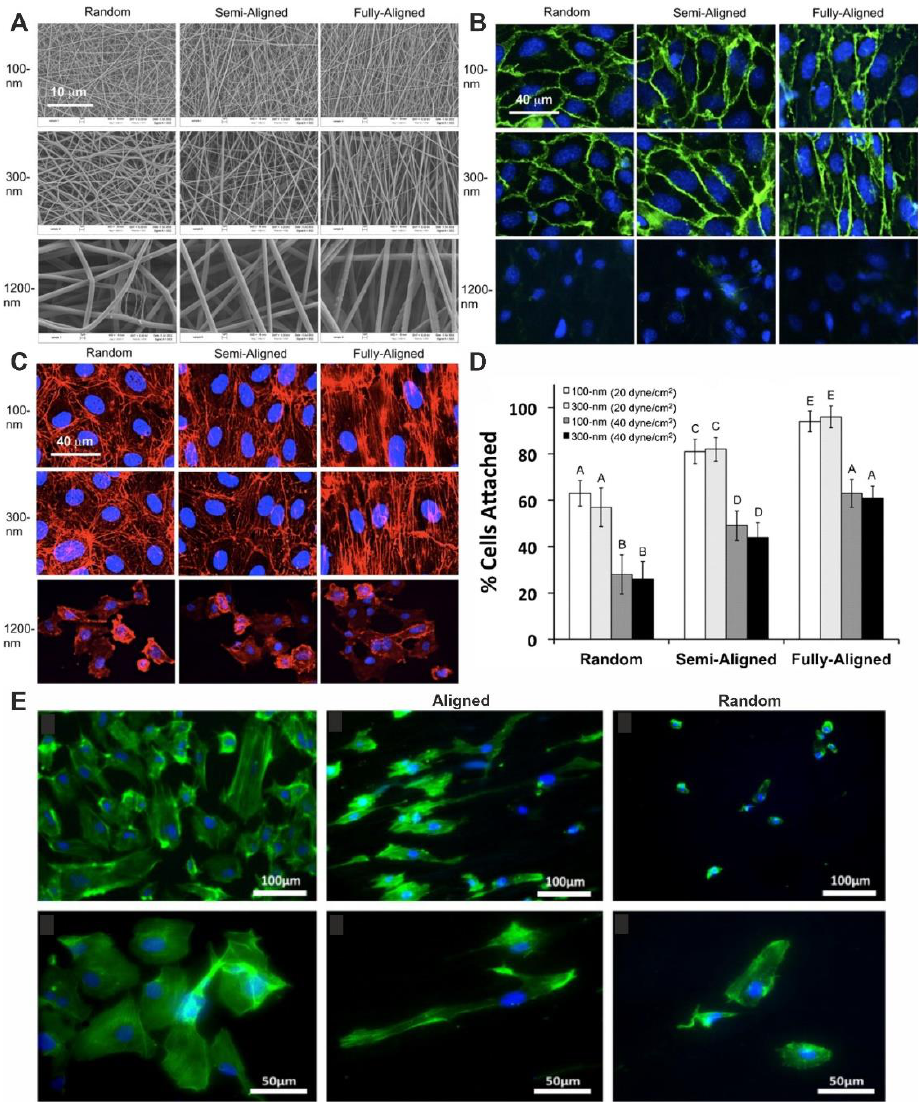
Figure 4. The effect of the scaffold’s fiber orientation on HUVEC morphology and alignment on electrospun scaffolds. The influence of fiber orientation and medium flow on interaction of endothelial cells with scaffolds (reprinted from Ref. [49]. Copyright © 2013 Biotechnology and Bioengineering Inc. Published by Wiley Periodicals). SEM image of electrospun PCL/collagen scaffolds ( A ). Fluorescent images of cytoskeletal F-actin organization ( B ) and VE-cadherin expression ( C ) for endothelial cells on scaffolds with varying fiber diameters and orientations. The number of cells that adhered to materials after 60 min of continuous hydrodynamic shear stress ( D ). Image ( E ) was obtained by fluorescent microscopy (cells were cultured with different scaffolds for five days and stained with Alexa Fluor 488 Phalloidin and DAPI) (reprinted from Ref. [51]. Copyright © 2011 Acta Materialia Inc. Published by Elsevier Ltd.)